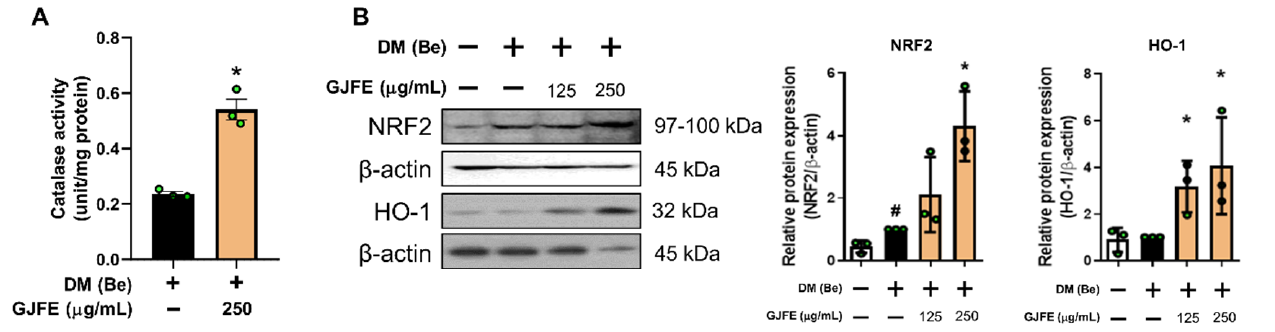
Figure 6. Effect of GJFE on oxidative stress in beige-induced 3T3-L1 cells. ( A ) Catalase activity was measured in beige-induced 3T3-L1 cells treated with GJFE (250 μg/mL). ( B ) Protein levels of NRF2 and HO-1 were analyzed by Western blot analysis. ( C ) DCF-DA staining was performed at 24 h and 48 h post GJFE treatment in beige-induced 3T3-L1 cells (magnification 400×, scale bar 75 μm). β- actin was used as a loading control for Western blot analysis. All data are expressed as the mean ± SEM of the data from three or more separate experiments. # p < 0.05 vs. DM (Be)-untreated 3T3-L1 cells, * p < 0.05 vs. DM (Be)-treated 3T3-L1 cells. GJFE, Gardenia jasminoides fruit extract. 3.7. Thermogenic Effect of GJFE in Beige Adipocytes Depends on the PPARγ Activation We found that GJFE markedly increased PPARγ in the beige- and white-induced 3T3-L1 cells, thus we sought to investigate its detailed molecular mechanism. First, to con- firm the significance of PPARγ on UCP1 expression, 3T3-L1 cells were differentiated in the presence/absence of the PPARγ agonist Rosi. The absence of Rosi during differentia- tion resulted in a markedly reduced expression of both the Pparg and Ucp1 genes (Figure S5), suggesting that PPARγ is an important factor of thermogenic alteration in adipocytes. The PPARγ inhibitor GW9662 did not affect the viability of the 3T3-L1 cells at concentra- tions lower than 0.5 μM (Figure 7A). GW9662 indeed suppressed the PPARγ expression